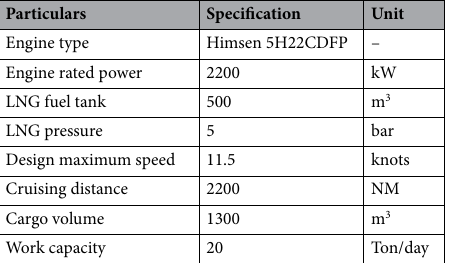
Table 1. Principal particulars of prototypical cleaning vessel.